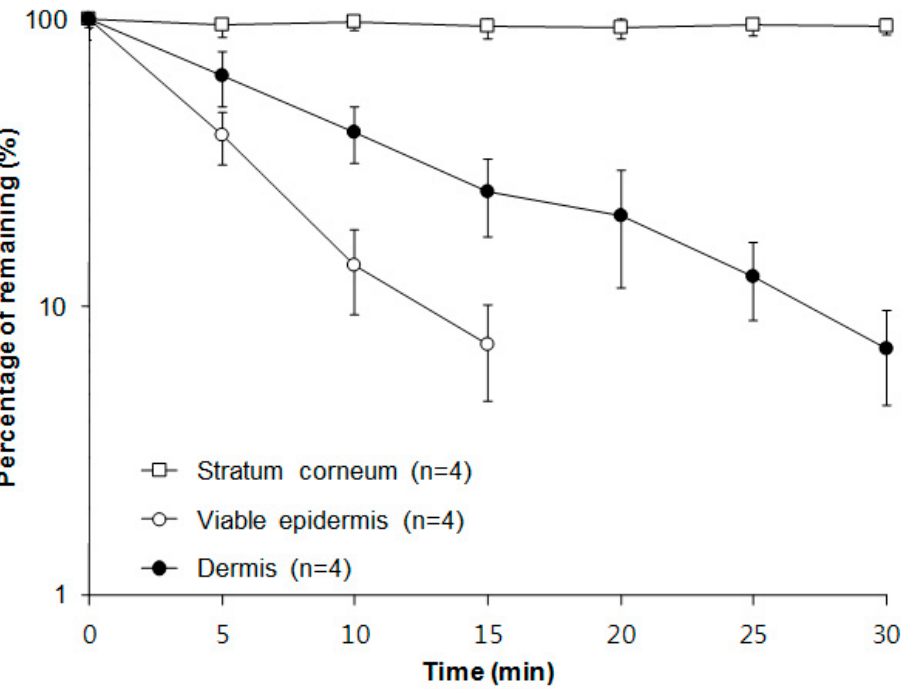
Figure 1. Extraction recovery of melittin from stratum corneum, viable epidermis, and dermis.